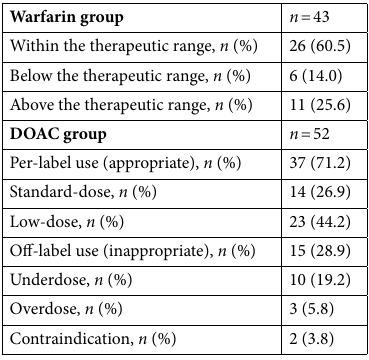
Table 2. Dosage and therapeutic ranges of DOACs and warfarin.